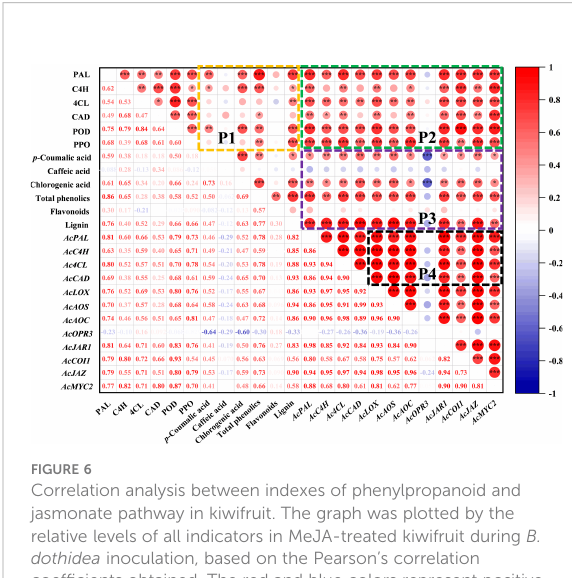
FIGURE 6 Correlation analysis between indexes of phenylpropanoid and jasmonate pathway in kiwifruit. The graph was plotted by the relative levels of all indicators in MeJA-treated kiwifruit during B. dothidea inoculation, based on the Pearson ’ s correlation coef fi cients obtained. The red and blue colors represent positive and negative correlations, respectively. * P < 0.05; ** P < 0.01; *** P <